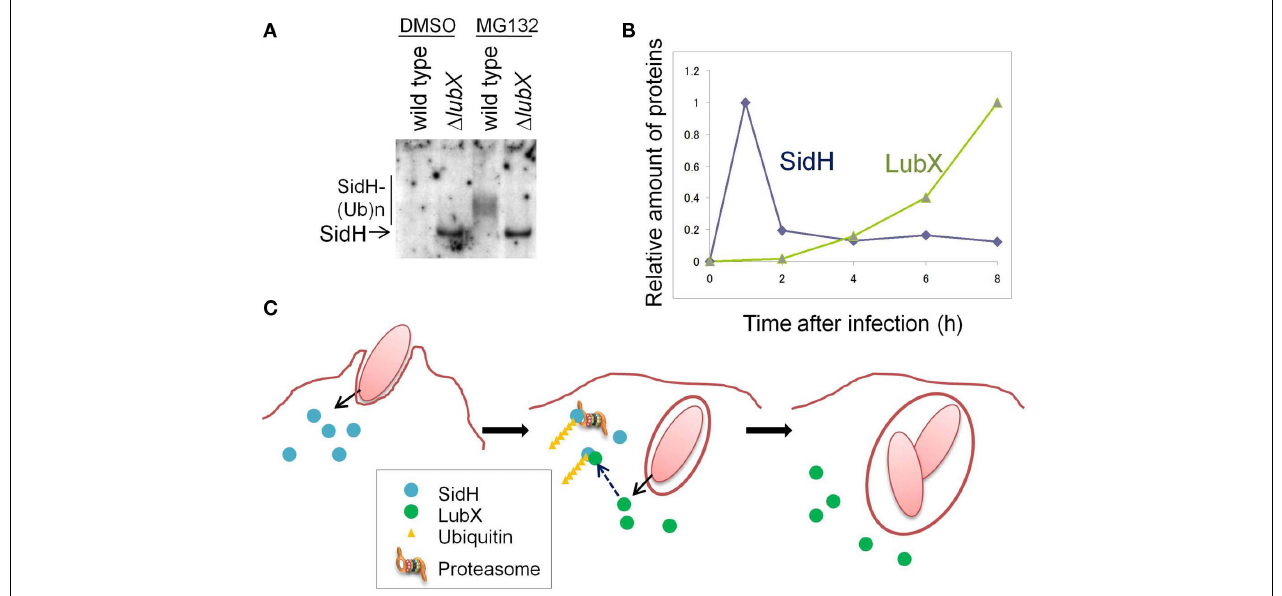
is reproduced from Kubori et al. (2010) under the Creative Common Attribution License. (B) Time course of the relative amounts of SidH and LubX in the cells infected with the wild-type L. pneumophila strain. (C) A model of the temporal regulation of SidH. SidH is delivered via Legionella T4SS just after infection (left panel). Compared with SidH, LubX synthesis, and delivery is delayed. SidH is polyubiquitinated by the LubX ubiquitin ligase (middle panel), which leads to degradation of SidH by the host proteasome (middle and right panels).This panel is adopted from Kubori et al.